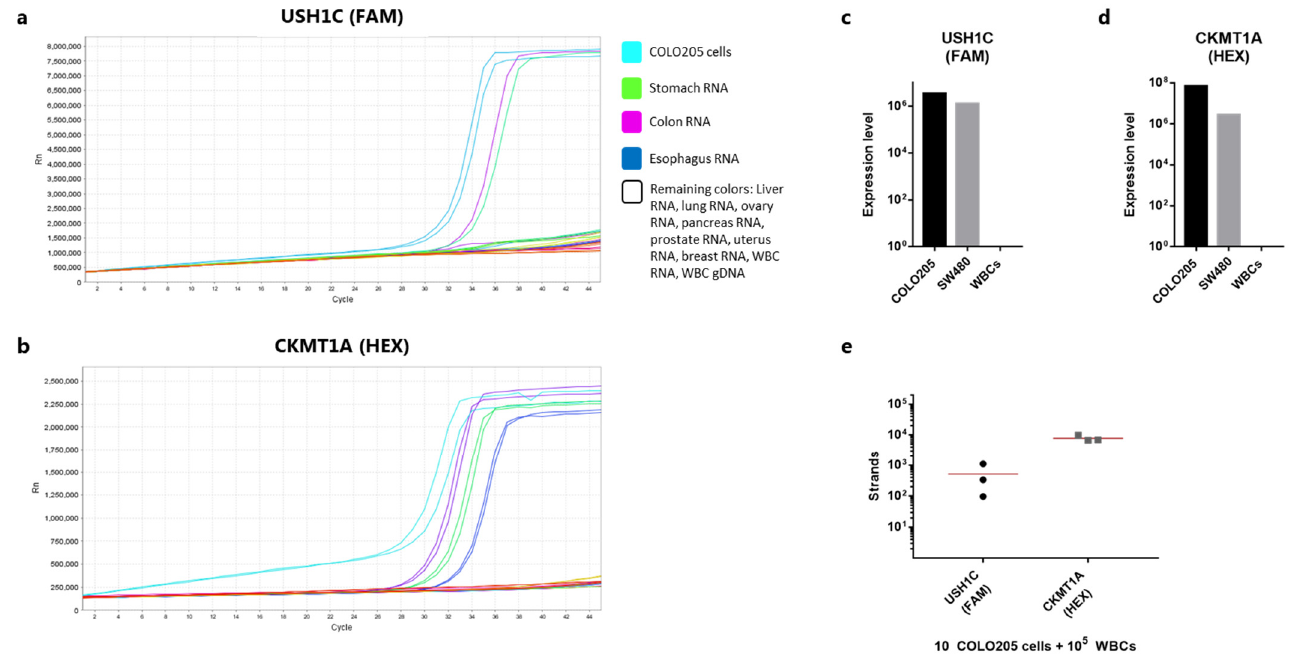
Figure 2. Validation of RNA markers for cancer cell detection. ( a ) Amplification curve showing the RT-qPCR reaction (one step) using primers and probes targeting USH1C (detected in the FAM channel). Samples tested include lysed COLO205 cells, RNA derived from a range of human tissues (explained in the color legend), and genomic DNA from white blood cells. All samples were tested in duplicates. ( b ) As in ( a ), but with primers and probes targeting CKMT1A (detected in the HEX channel). ( c ) Number of detected strands of USH1C cDNA from 1000 lysed COLO205 or SW480 cells measured by qPCR after RNA extraction, RT-PCR and pre-amplification. 100,000 WBCs were included in the procedure as a negative control. ( d ) As in ( c ), but showing the number of CKMT1A strands. ( e ) Number of cDNA strands of USH1C or CKMT1A detected from 10 COLO205 cells spiked in 100,000 white blood cells and directly lysed (n = 3). RNA was extracted and cDNA converted before being quantified by qPCR. Lines represent the